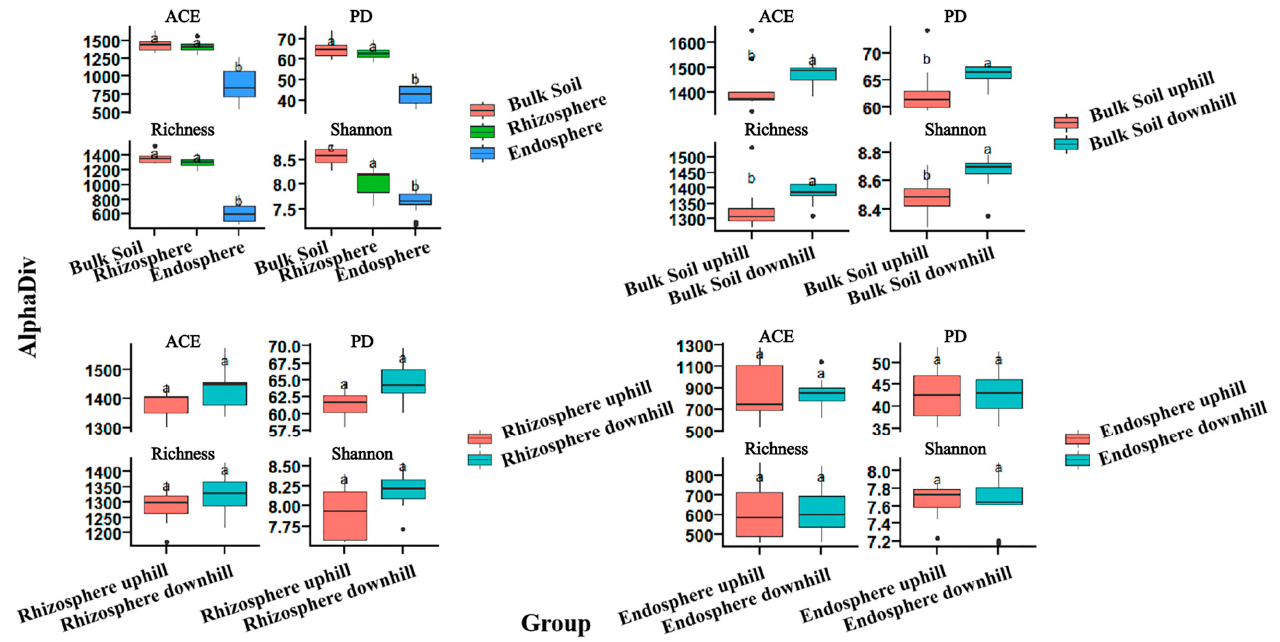
Figure 2. Alpha diversity indices of bacterial communities in root endosphere, rhizosphere, and bulk soil samples, including estimates such as abundance-based coverage estimator (ACE), Faith’s phylogenetic diversity (PD), richness, and Shannon index. Different letters represent significance at p < 0.05.